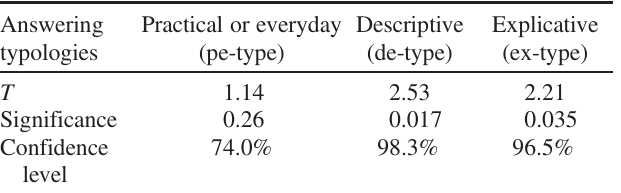
TABLE IV. Student paired T -statistic results for the comparison between the research sample ’ s outcomes collected immediately after instruction and four years